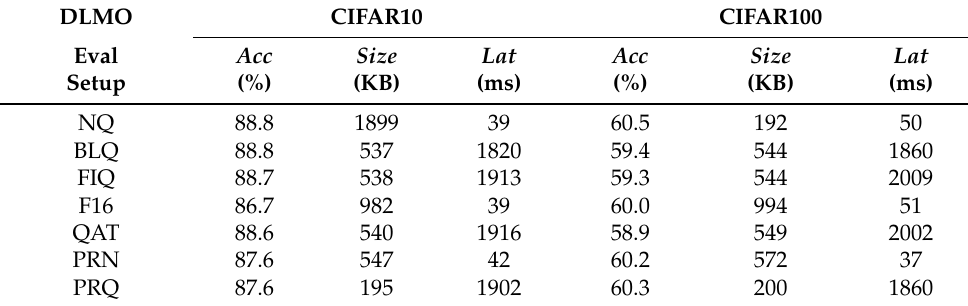
Table 13. Wide Residual